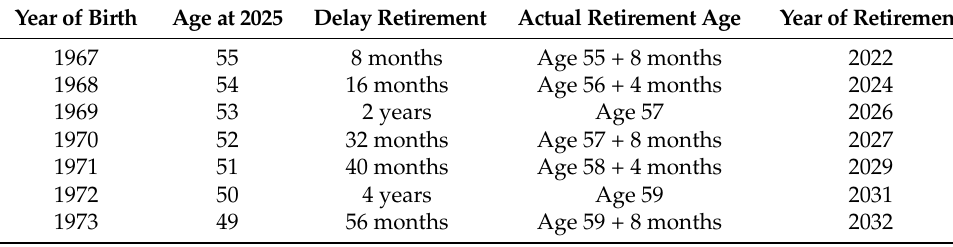
Table 8. Delayed retirement plan I (female